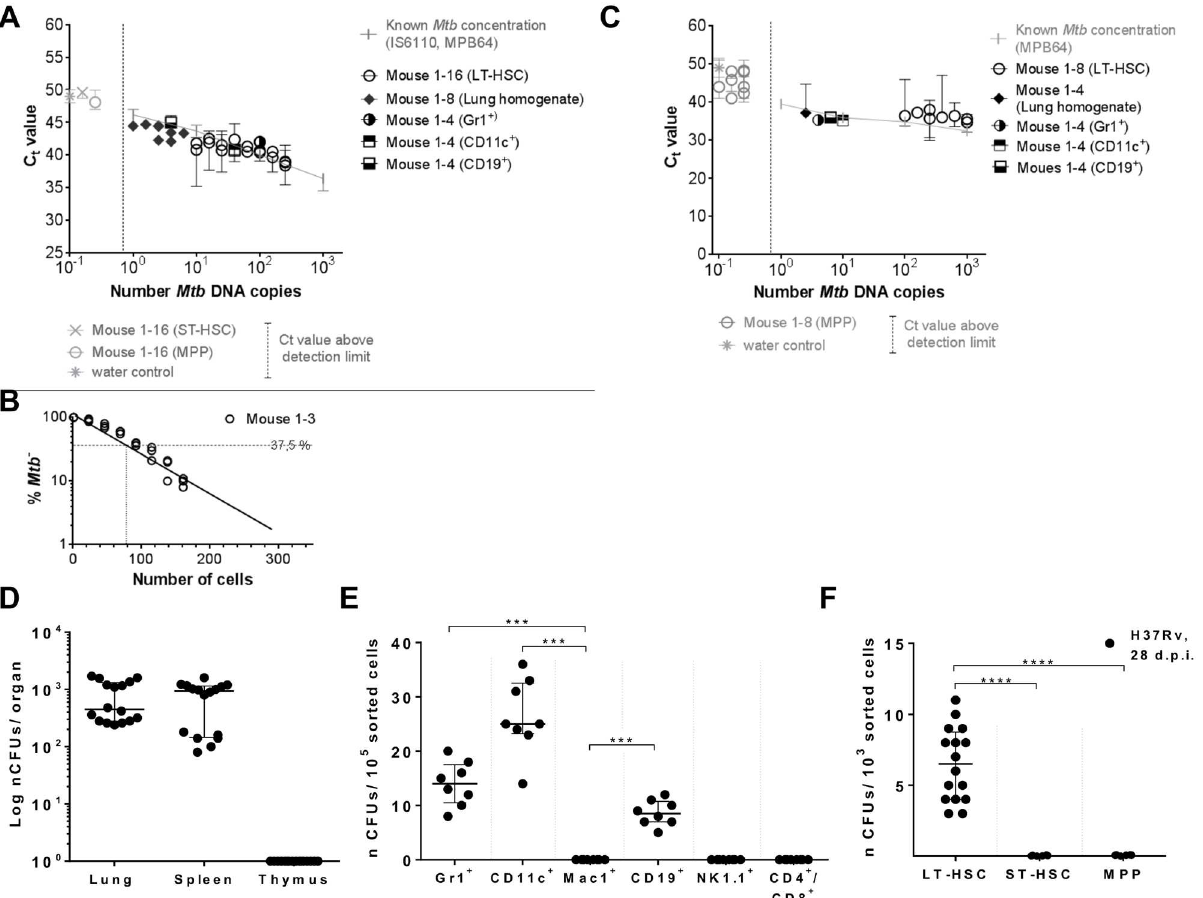
Fig 2. Detection of Mtb infection in different organs and hematopoietic cells of mice day 28 p.i. by Mtb DNA PCR and Mtb CFU. C57BL/6 mice were infected with 10 5 CFUs Mtb (H37Rv). (A) Quantificationof Mtb -specific DNA by real-time TaqMan PCR using probes targeting MPB64 and IS6110 (S4 Fig) on genomicDNA of 10 5 lung cells (n = 8), 10 5 Gr1 + , CD11c + , CD19 + , Mac1 + , NK1.1 + , CD4 + /8 + cells (n = 4; S1C Fig), and 10 3 LT-pHSCs, ST-pHSCs and MPPs (n = 16; S1B Fig). (B) Quantification of Mtb -specificDNA by limitingdilutions using a single-target PCR for IS6110 (n = 3; S2B Fig). (C) Real-timeSYBR green PCR using primers targeting MPB64 (n = 4–8; S4 Fig). Real-timePCRs were performed in 2 independentruns in technicaltriplicates and normalized to murineGAPDH. Known Mtb concentrations were used as reference. (D) CFU enumeration on Middlebrook7H11 agar in cells of lung, spleen and thymus (n = 16). (E) CFU enumeration on Middlebrook7H11 agar for Lin + cell populations (n = 8). (F) CFU enumerationon Middlebrook 7H11 agar for hematopoietic progenitors (n = 16). Shownare data of 4 independentexperiments. Data are shown as median+ interquartile. * P < 0.05, ** P < 0.005, *** P < 0.0005, **** P < 0.00005by Mann-Whitney